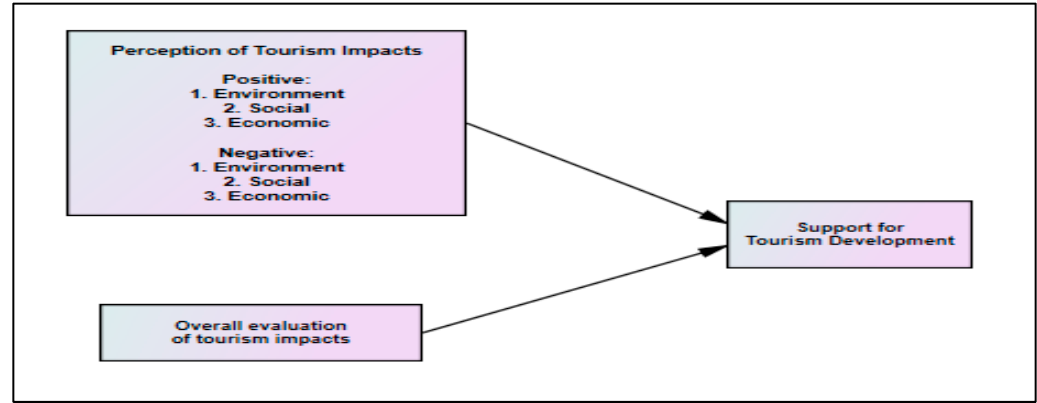
Figure 1. Theoretical Framework.